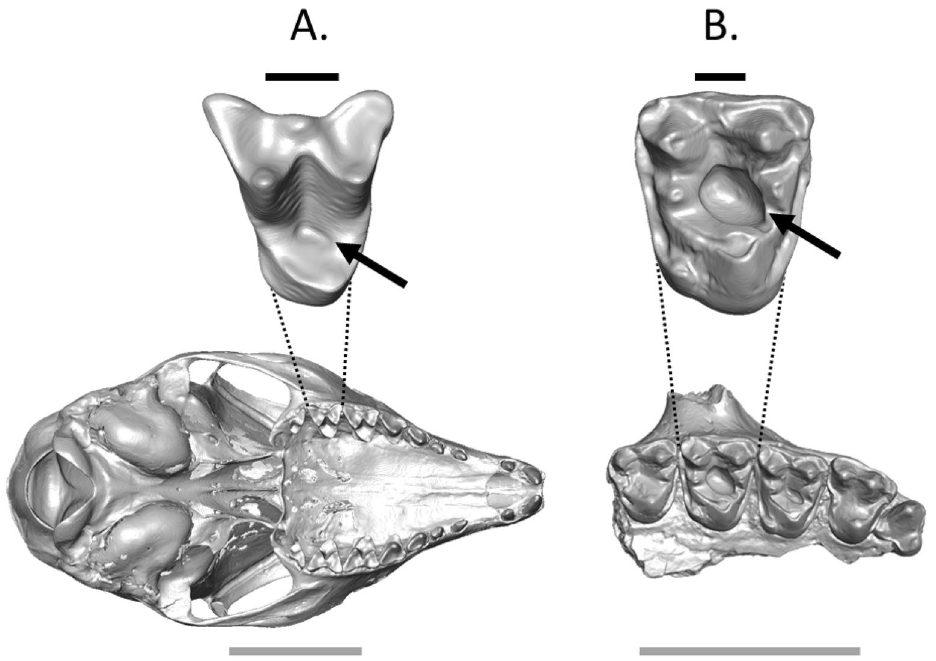
Figure 2. Micro-CT reconstruction of ( A ) the cranium of the extant treeshrew Tupaia gracilis (AMNH 103620) and ( B ) the right upper jaw fragment (P 3 –M 3 ) of M. latidens (USGS 17748) with carious lesions.